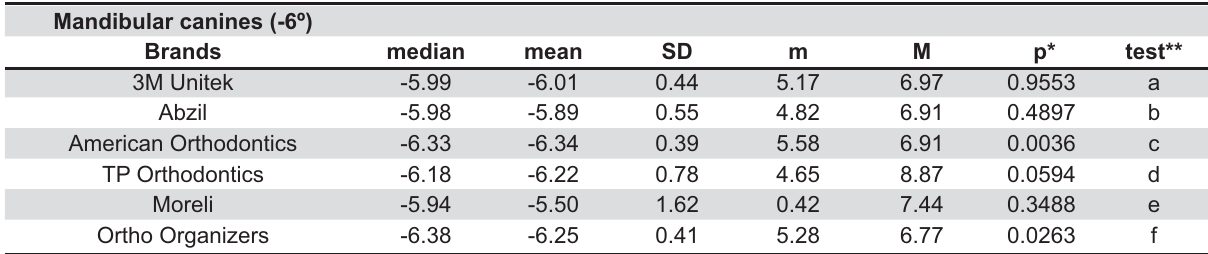
Table 4- Comparison of the mean torque value found for each bracket brand and the prescribed value for mandibular canines and intergroup Mandibular canines (-6º)